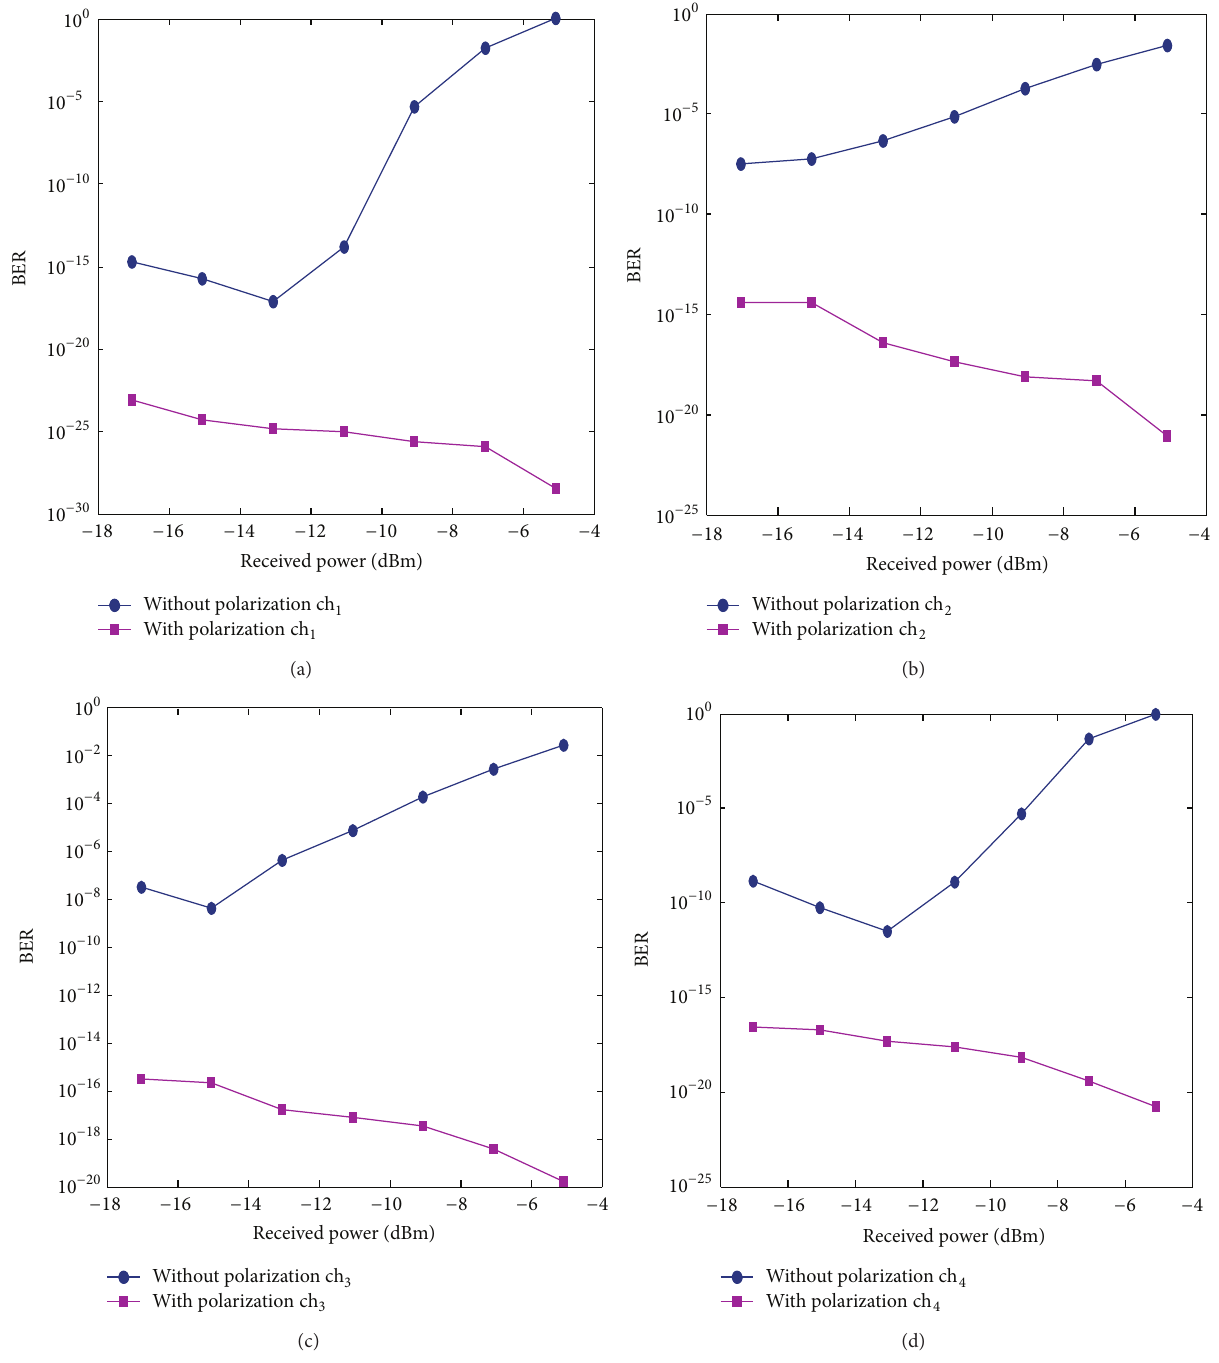
Figure 6: Received power versus BER in the presence and absence of the polarization techniques using DSF at (a) ch 1 , (b) ch 2 , (c) ch 3 , and (d) ch 4